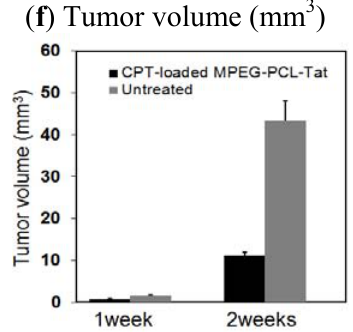
( f ) Tumor volume (mm 3 )